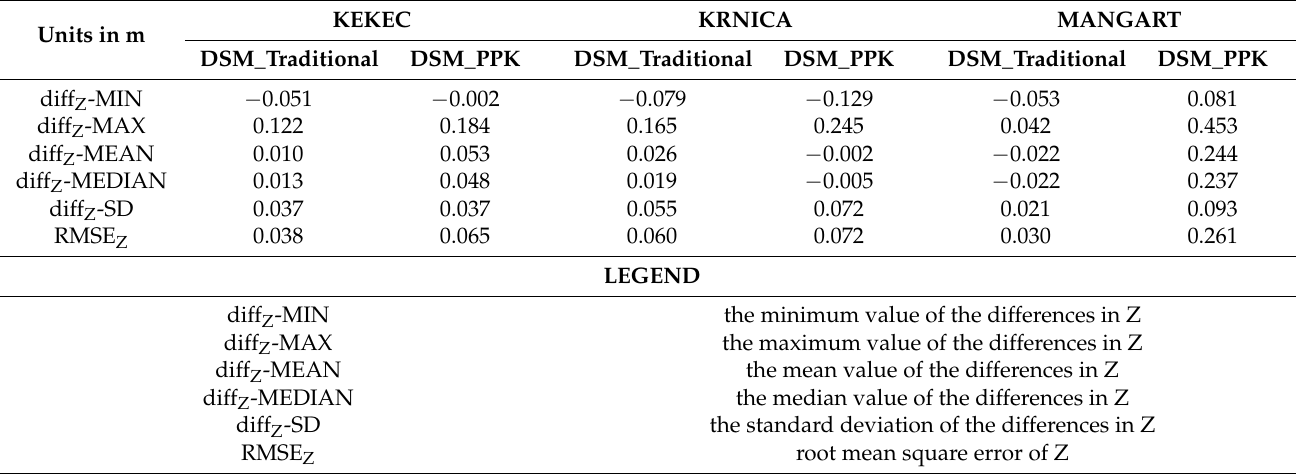
Table 5. Basic statistics for differences in Z coordinate measured in the field by total station and obtained by the DSM_traditional or